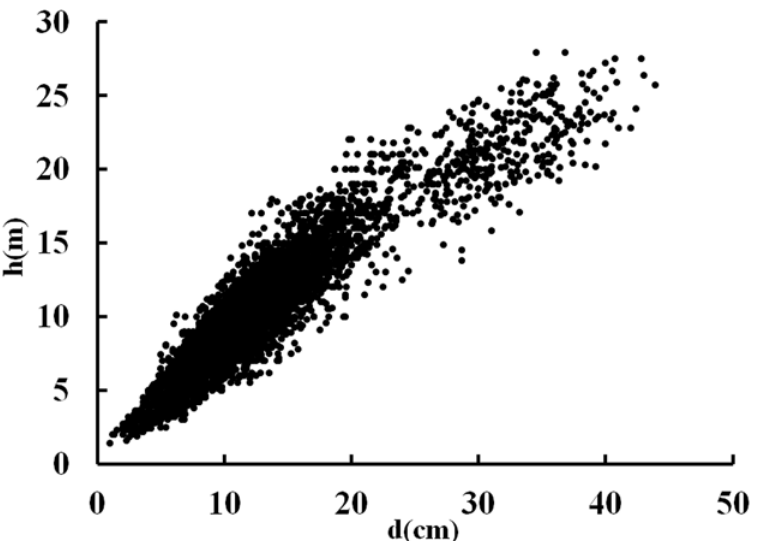
Fig 2. Scatter graph of individual height and dbh in Chinese-fir